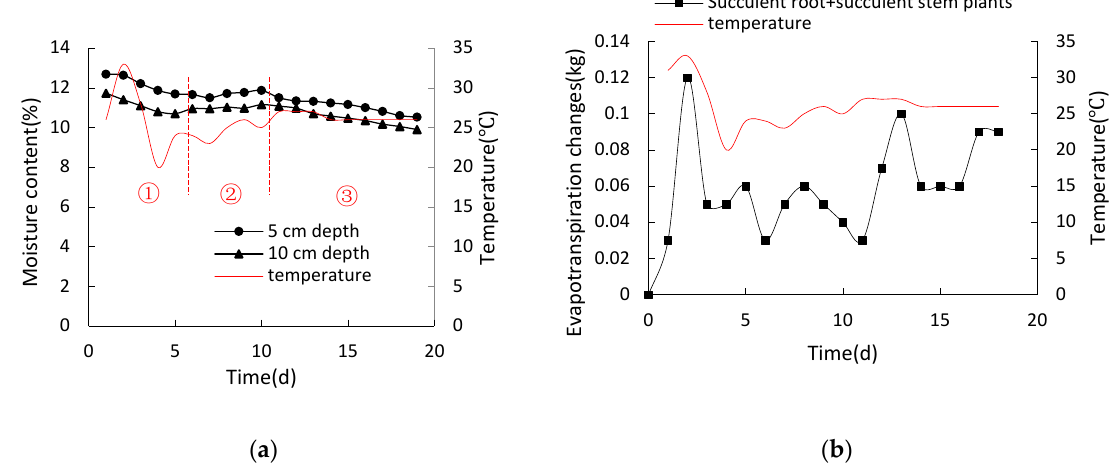
Figure 22. Response of water change with time and temperature in group 3 with water stored in both succulent root and succulent stem plants in drying stage: ( a ) Relationship curve of moisture content and temperature versus time at 5 cm and 10 cm sub-surface; ( b ) Relationship curve of evapotranspiration change and temperature versus time.